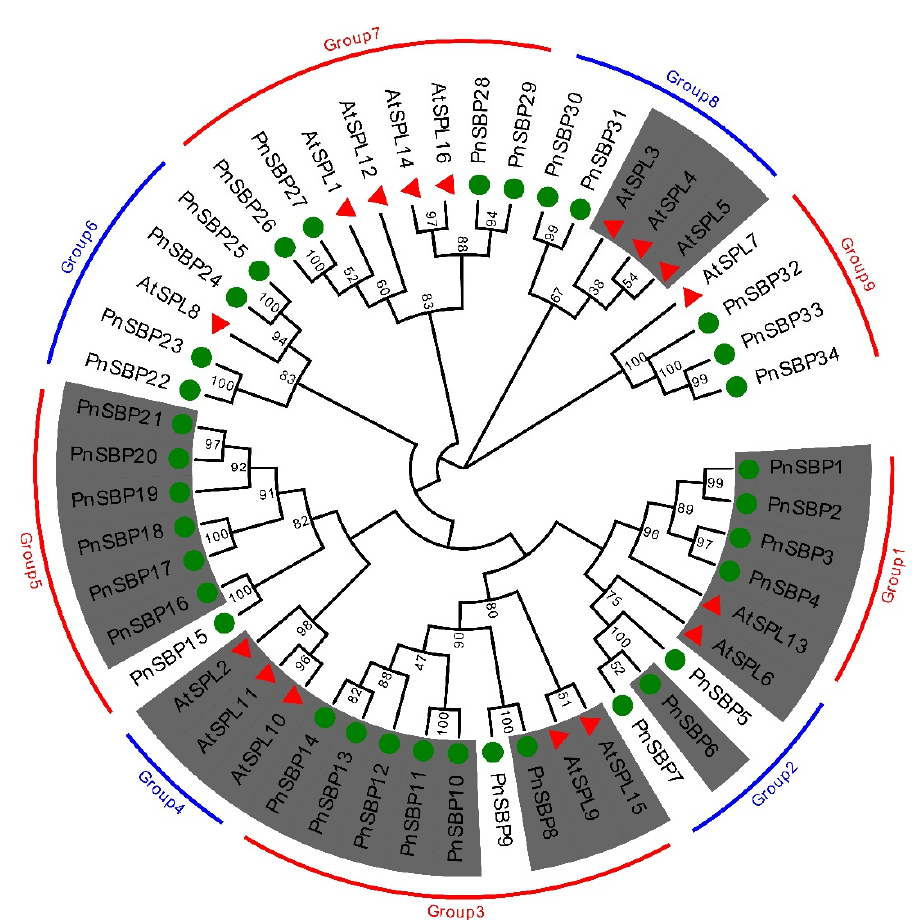
Figure 1. The phylogenetic tree of pepper SBP genes. The red triangles refer to SBP genes of A. thaliana ; the green balls refer to pepper SBP genes. Each group is highlighted with a color stripe. The SBP genes with miR156 target site were marked with dark background color.